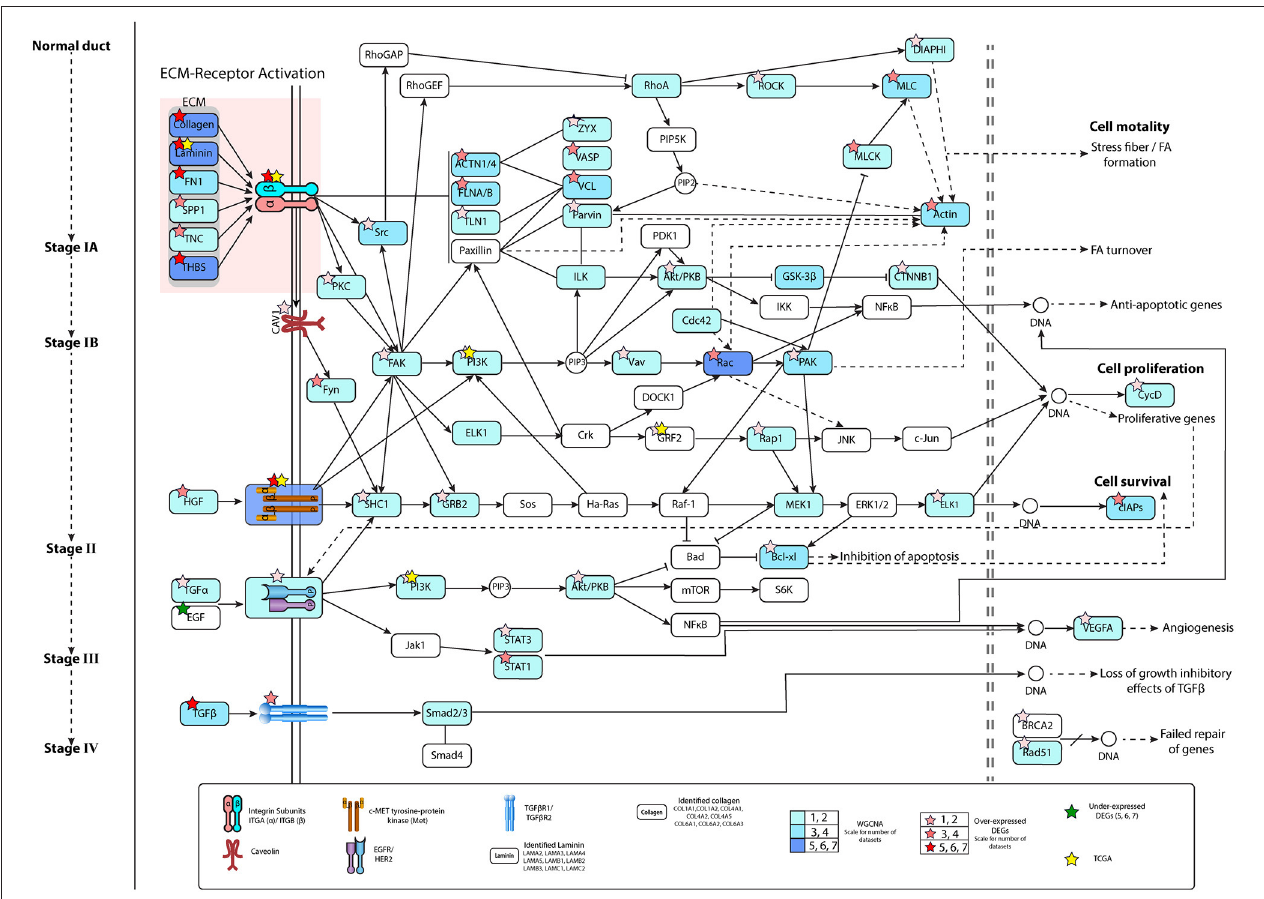
FIGURE 3 | Pathway representing pancreatic cancer (PaCa) progression from normal pancreas cell to invasive stage of cancer. ECM molecules initiate multiple signaling pathways by interacting with integrin complexes. The growth factor receptors MET and EGFR/HER2 activation in initial stages of PaCa, activates signaling cascades, which lead to expression of anti-apoptotic, proliferative, and cell survival genes. Figure represent the information related to gene identified in number of datasets in WGCNA and differential gene expression (DE) analysis. Color filled in entities show the dataset number for WGCNA. Color of stars represent number of DE